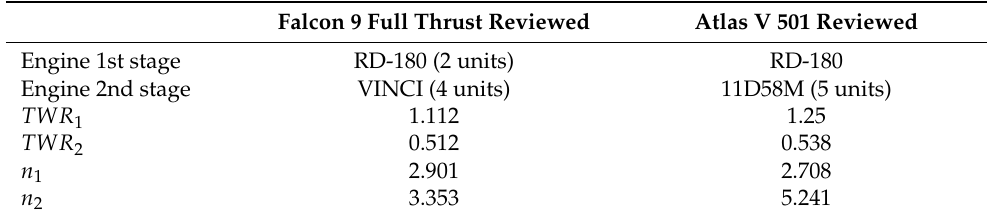
Table 6. Comparison of the optimization variables of the revision, with respect to the real rocket.